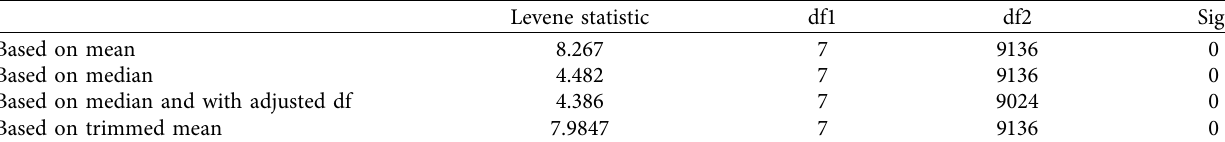
Table 3: The results of homogeneity test of variances on personality development qualities in Madras group. Levene statistic df1 df2 Sig.